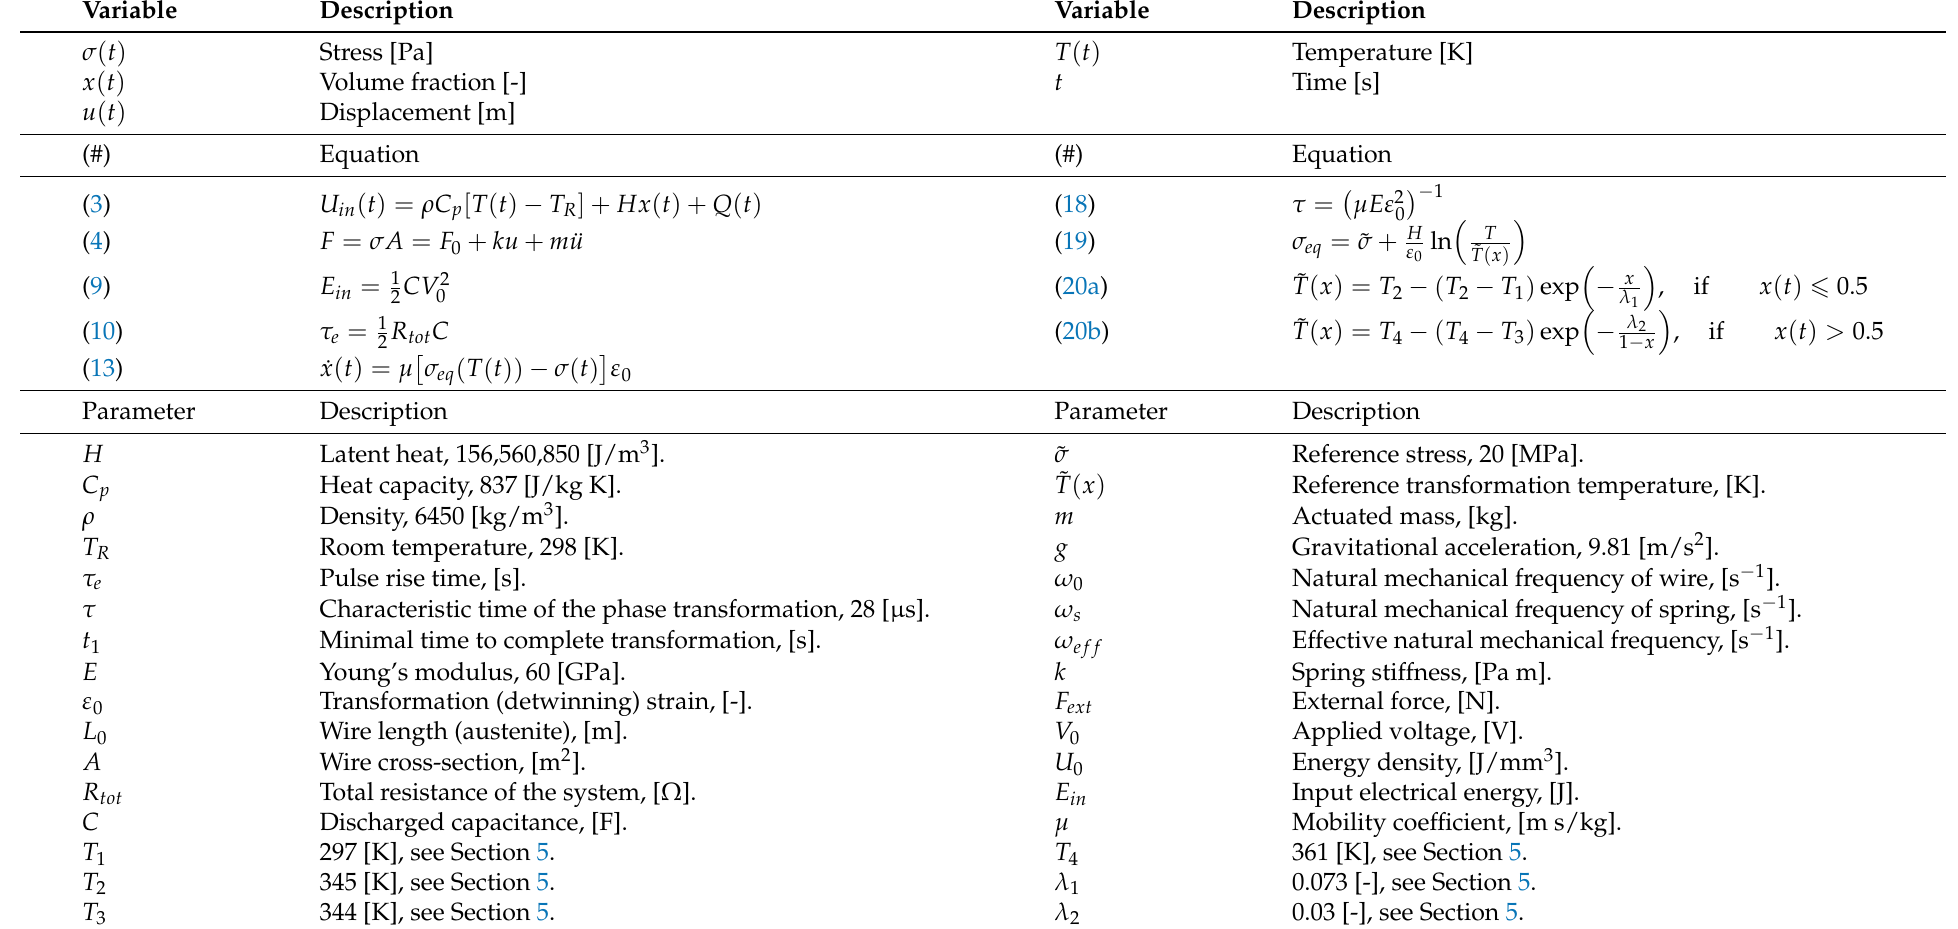
Table 2. Collection of the main variables, equations and parameters used in the formulation of the